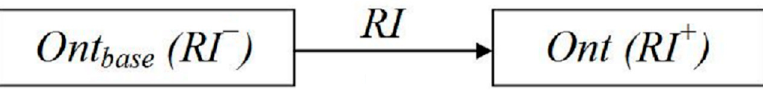
Figure 1. Simple extensive development of ontology.